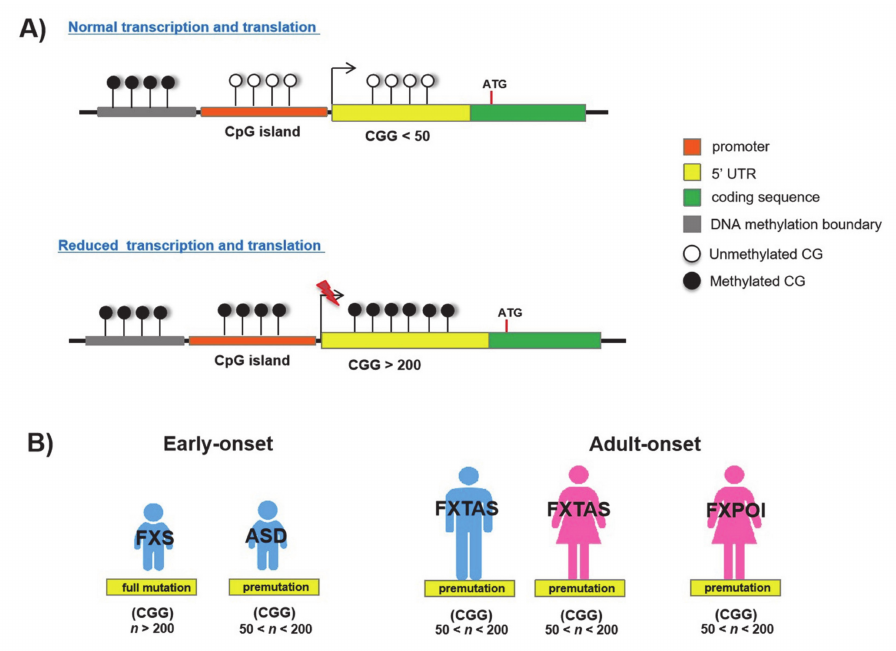
Figure 3. CpG island and CGG repeat in FMR1 locus: ( A ) Normal and hypermethylated promoter regions; ( B ) CGG-expanded repeats in FXS-allelic